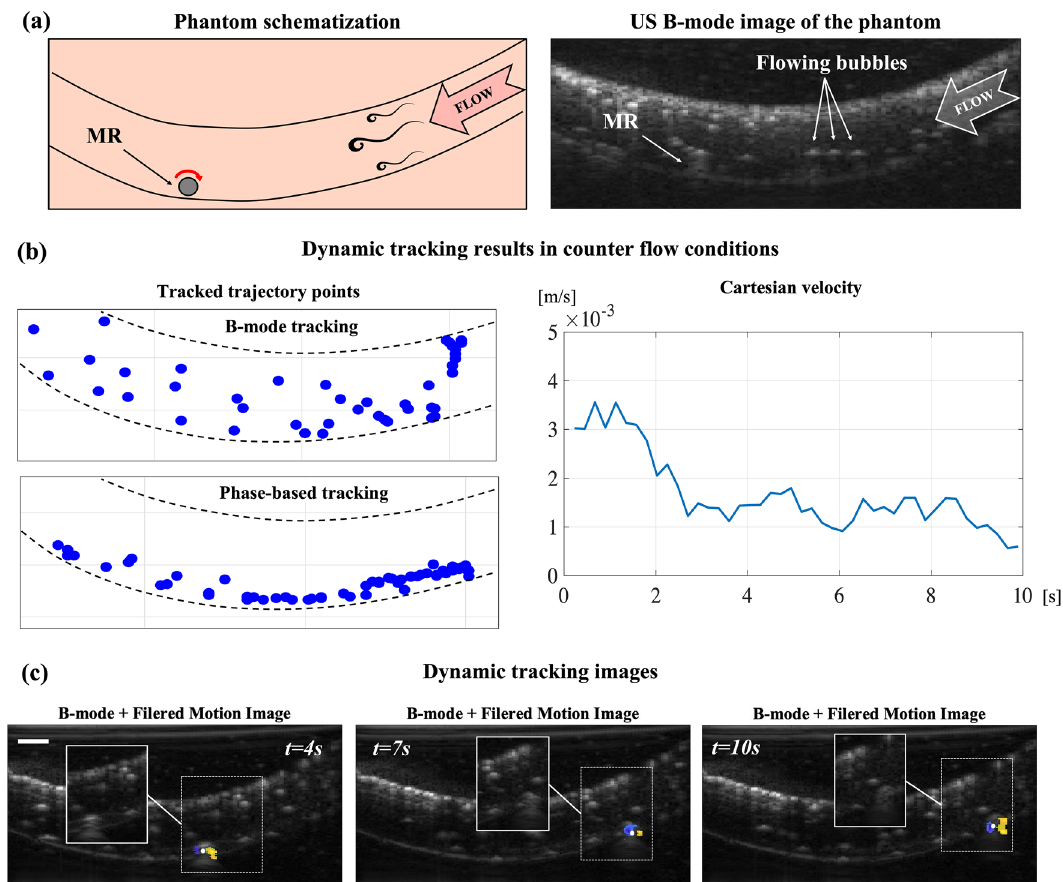
Figure 5. Dynamic MR tracking in echogenic counter fluid flow. ( a ) Schematization of phantom for tracking experiments and corresponding B-mode image. ( b ) Results of trajectory tracking in the presence of an induced flow. The tracked trajectory points graph shows how the B-mode tracker is disturbed by distributed high contrast particles in the flow (bubbles), while the phase-based tracker can follow the MR robustly. The trend in the Cartesian velocity plot shows how the presence of an opposite flow introduces slip in the rolling motion, reducing the MR velocity until it eventually approaches zero when the MR runs across the inclined section of the lumen (t = 10 s). ( c ) Dynamic tracking images for different time instants during the experiment. The filtered motion images show MR contrast enhancement enabling robust detection even when the MR is barely visible in standard B-mode images (shown in image insets). The scale bar is 1